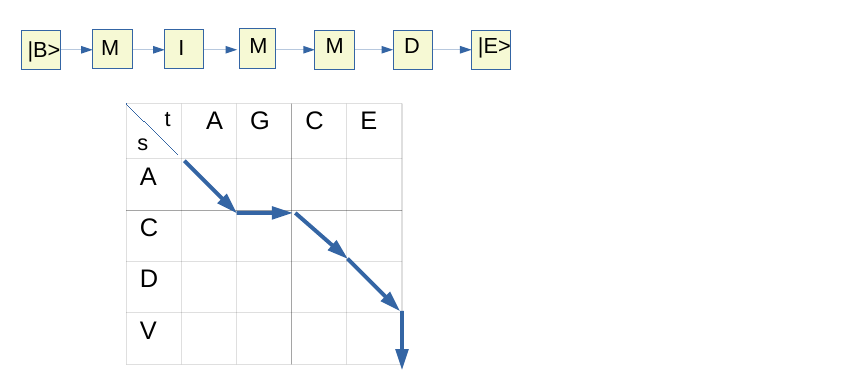
Figure 1. An example of simple pairwise alignment between a target sequence ( t ) and a structure sequence ( s ). Note that |B> denotes the BEGIN state and |E> denotes the END